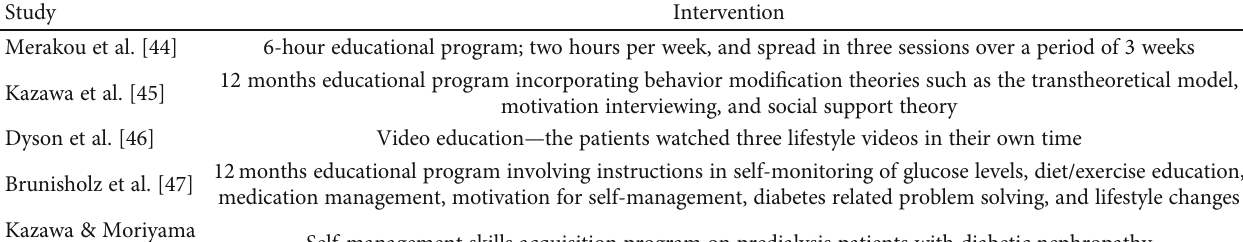
Table 3: Description of the interventions